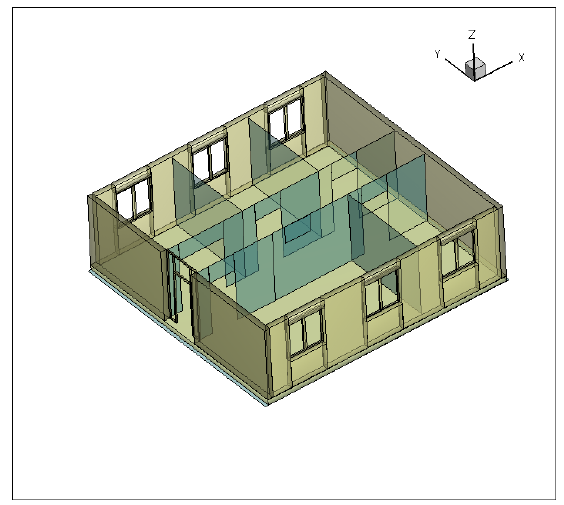
Figure 4: Geometry of the building.